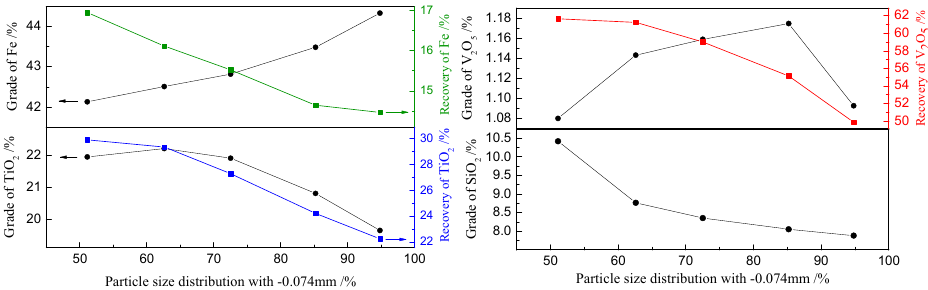
Figure 5. The effect of grinding fineness on low-intensity magnetic separation.